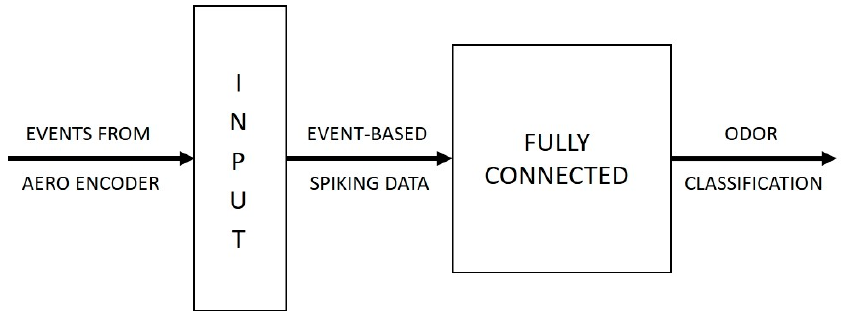
Figure 5. Block diagram representation of the Akida SNN implementation .